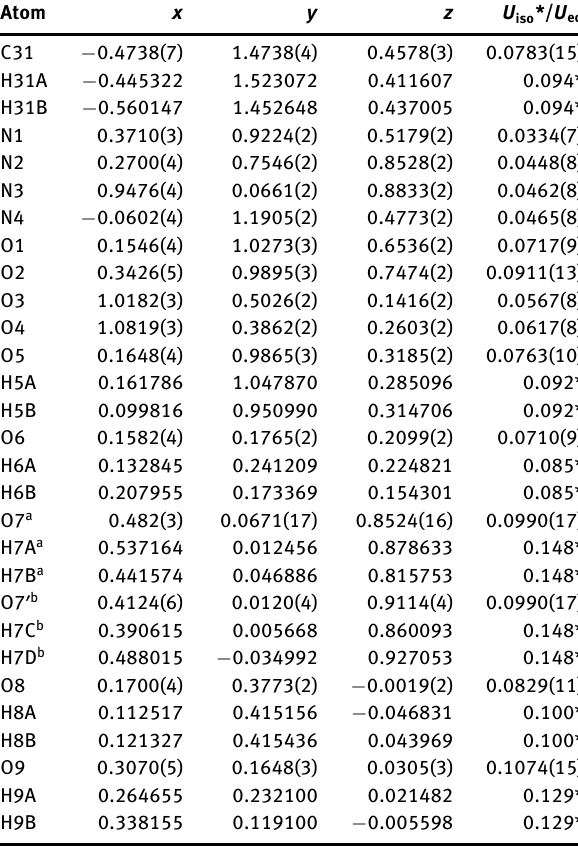
Table 2: Fractional atomic coordinates and isotropic or equivalent isotropic displacement parameters (Å 2